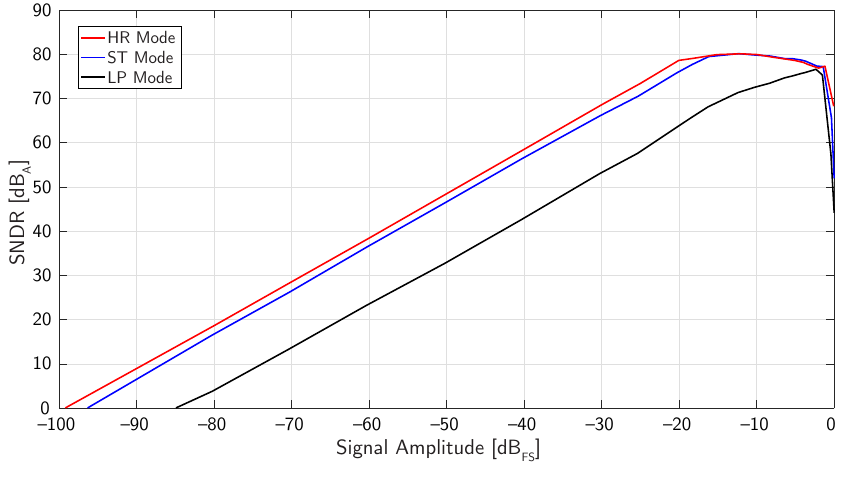
Figure 17. Measured SNDR as a function of the input signal amplitude in the three main operating modes (example 3).